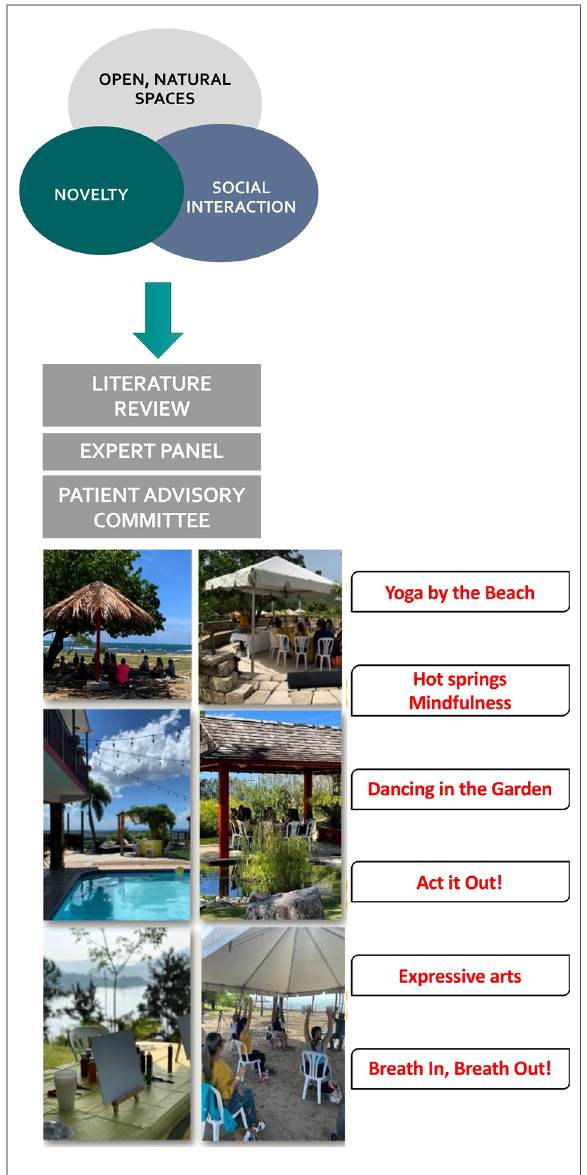
FIGURE 1 Translation of the EE paradigm to humans. A multidisciplinary team of experts, with input from a patient advisory committee, translated an enriched environment intervention based on the EE paradigm consisting of social support, novelty, and open spaces to be tested in a pilot psychosocial trial. EE interventions took place in open space venues (e.g., beach, lake, garden, hot springs, countryside) and consisted of a support group meeting (1 ½ h) and a novel stress-management activity (1 h). The interventions were conducted every other Saturday morning for a period of 6